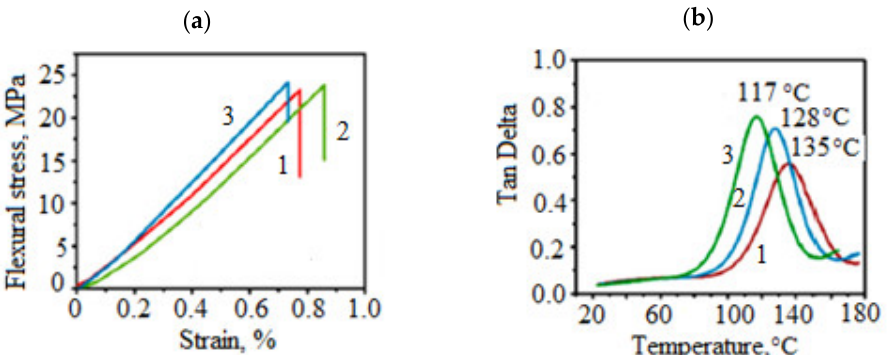
Figure 6. ( a ) Curves of bending stress versus strain of original and remanufactured composites. 1- pristine, 2- 1st reprocess, 3 – 2nd reprocess. ( b ) Tanδ versus temperature curves for the